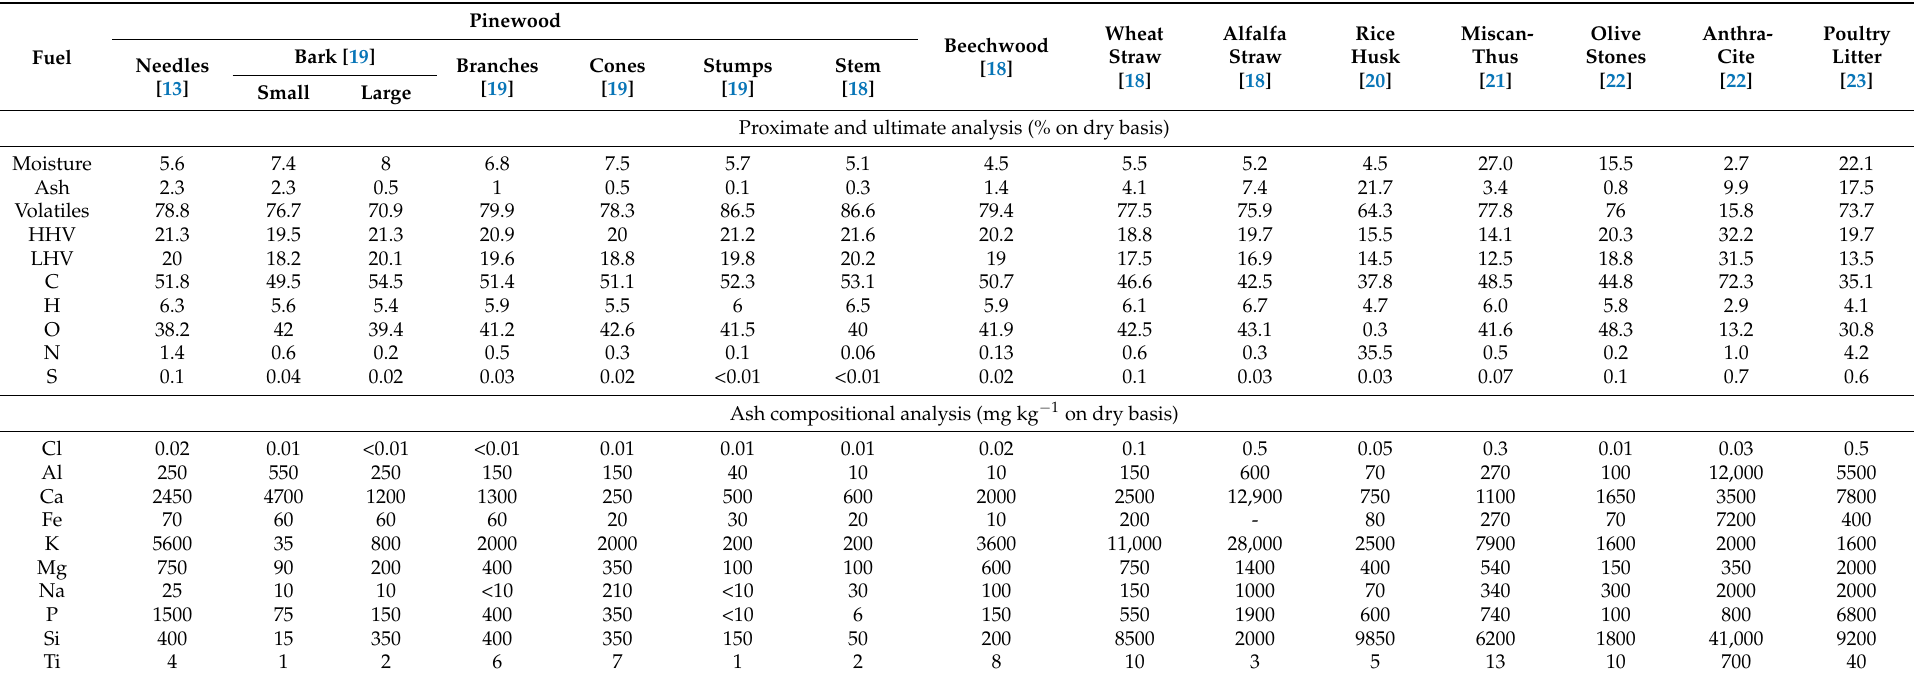
Table 2. Proximate, ultimate, and ash compositional analysis. HHV and LHV were calculated in MJ kg − 1 as